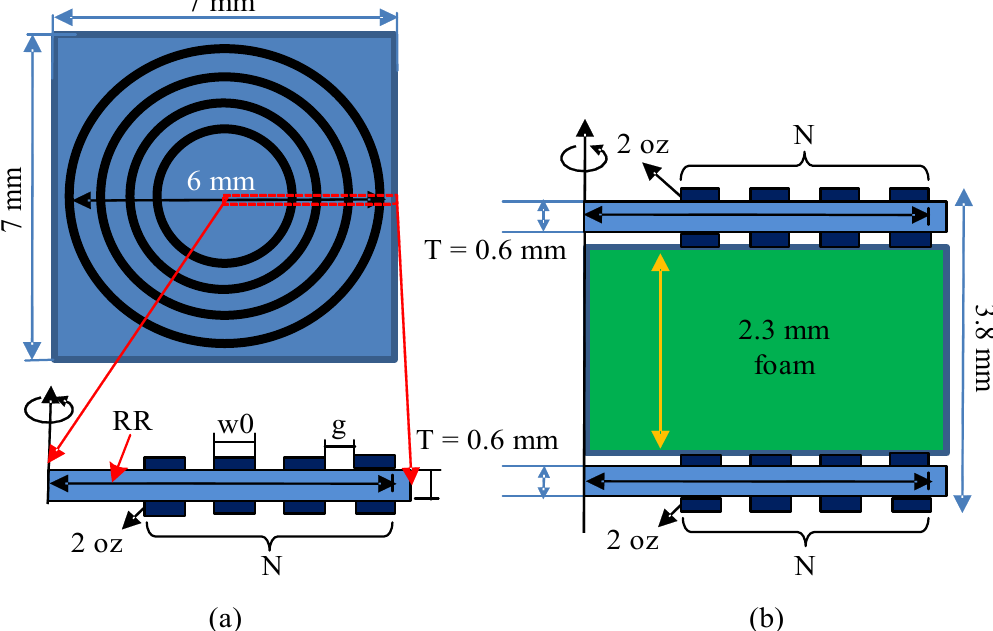
Figure 2. Schematic of a compact multilayer planar spiral coil, with the cross-sectional views of ( a ) the double-layer and ( b ) four-layer spiral coils. ( b ) four-layer spiral